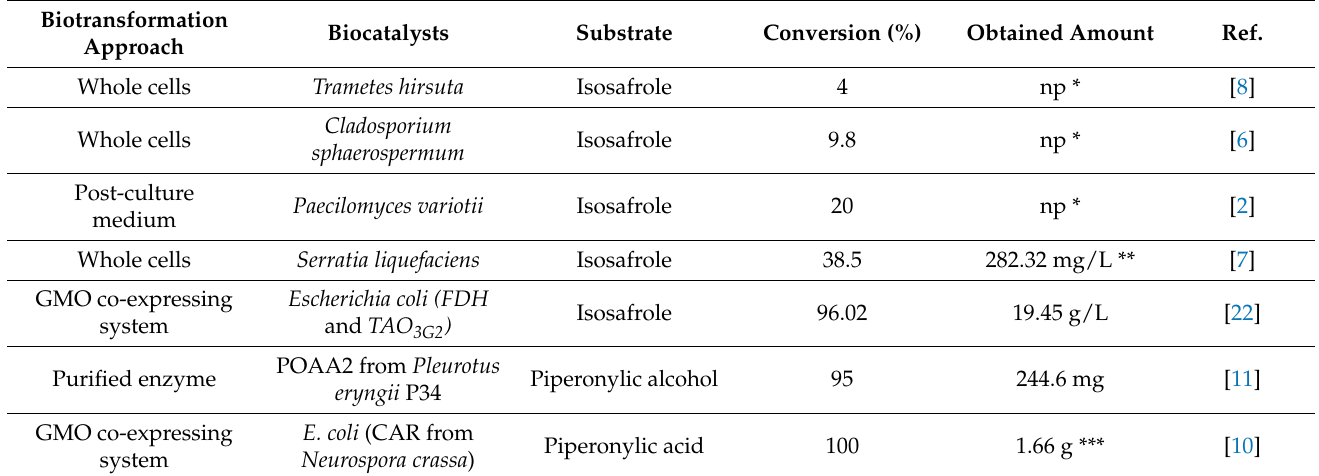
Table 6. Juxtaposition of the biotechnological approaches for obtaining piperonal ( 1b